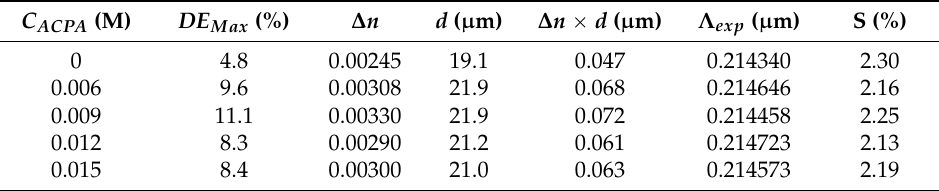
Table 3. Parameters obtained from the fitting of the gratings in Figure